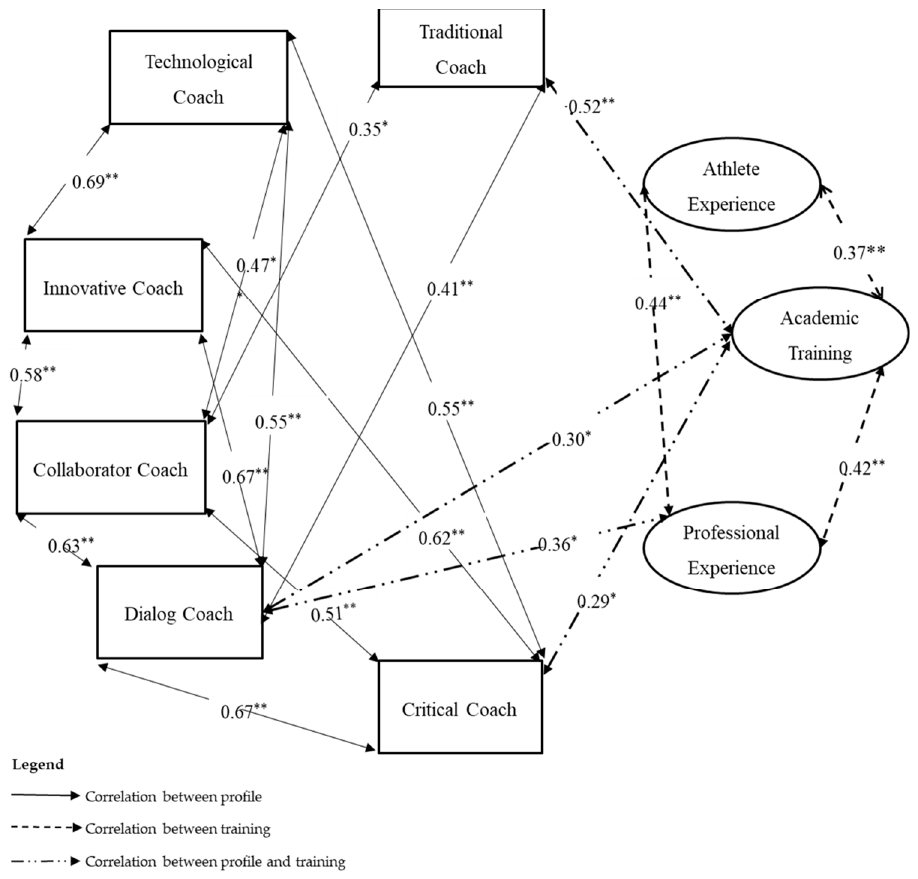
Figure 3. Correlations between the profile variables and SOPC training. * p < 0.005; ** p < 0.001.